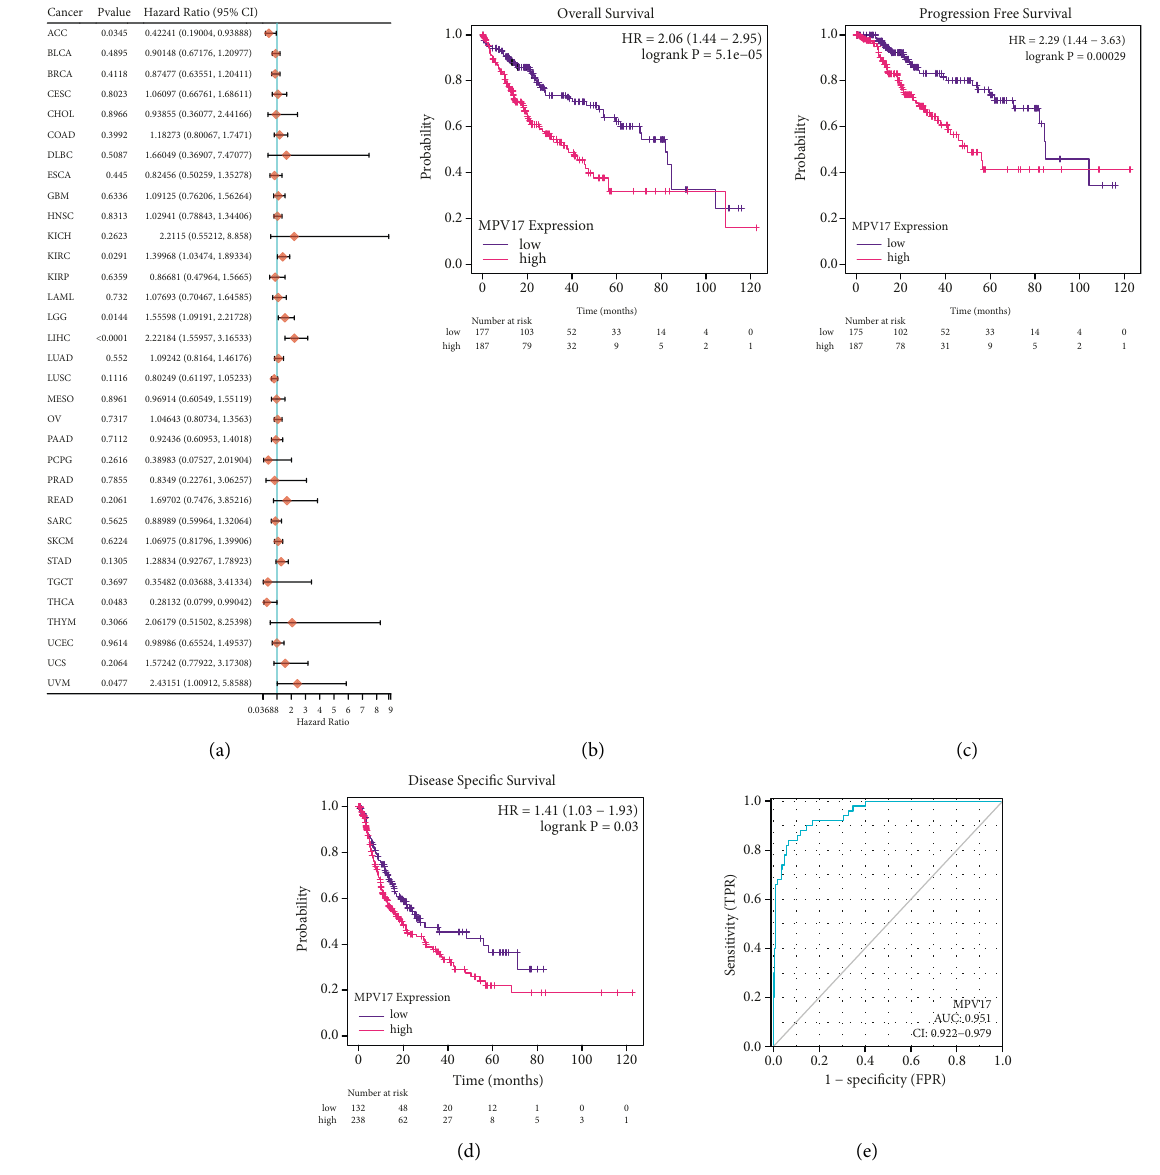
Figure 2: High expression of MPV17 is associated with poor prognostic status in LIHC patients. (a) Cox regression analysis on MPV17 and 33 types of tumors. (b–d) The Kaplan–Meier plotter analysis on LIHC patients with high and low MPV17 expressions in OS (b), PFS (c), and DSS (d). (e) ROC analysis on MPV17 (AUC �